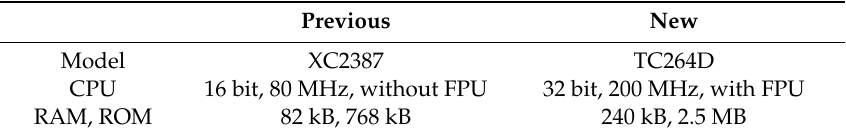
Table 4. Comparison of BMS hardware specification.